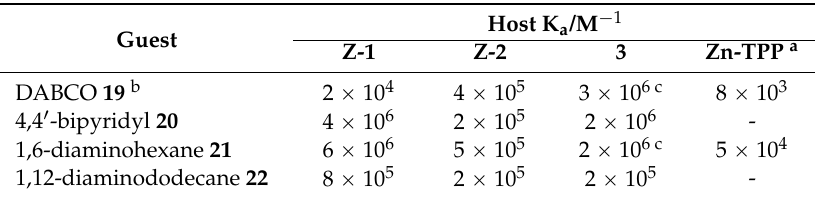
Table 4. Binding constants (K a , M ´ 1 ) (CH 2 Cl 2 solution, r.t.) for molecular tweezers Z - 1 , Z - 2 and 3 with selected dinitrogen compounds, determined by UV-vis